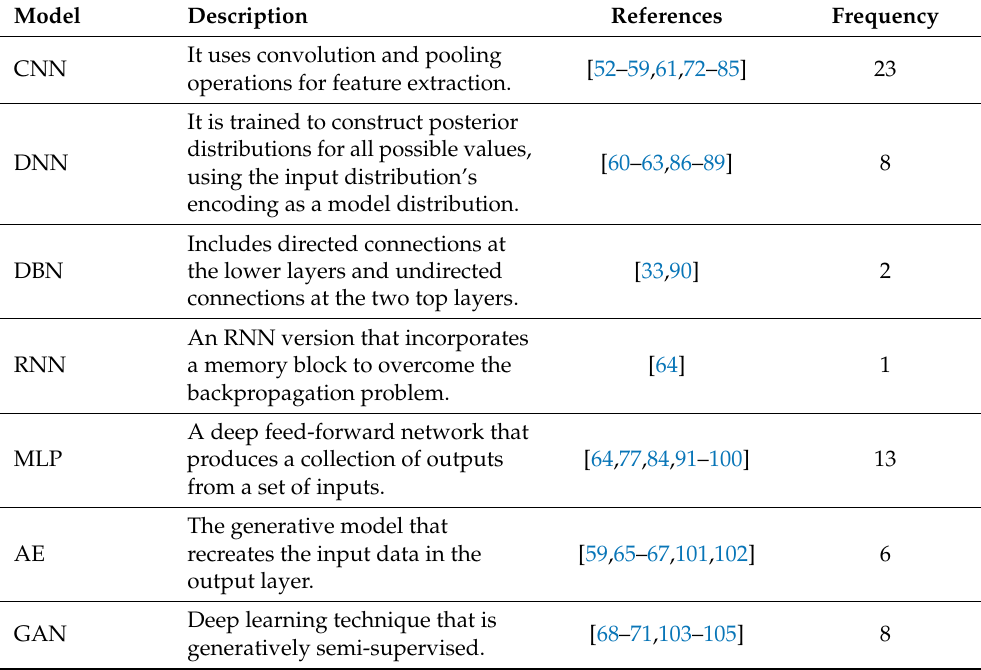
Table 4. The summary of the deep learning methods reviewed in this SLR.